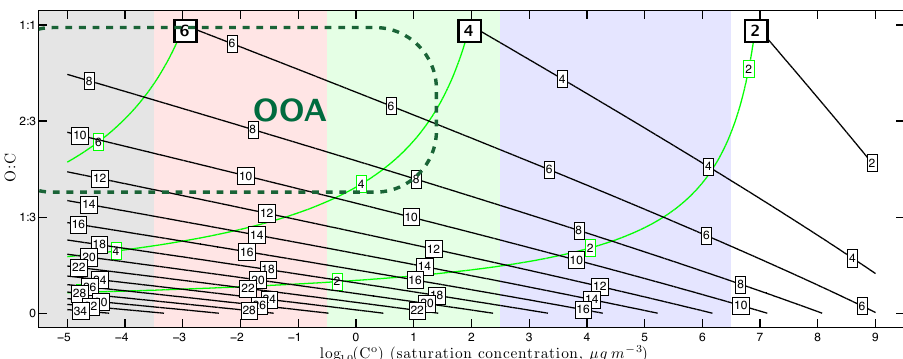
Fig. 4. Organic composition from the group-contribution method describing OA volatility, displayed in a 2-D space with volatility (log 10 C o ) on the x axis and oxygenation (O:C) on the y axis. Isopleths are for of constant carbon number ( n C , black lines) and oxygen number ( n O , green curves). The isopleths are shown for even numbers only. The rough range of oxygenated organic aerosol (OOA) seen in the atmosphere is shown with a dashed